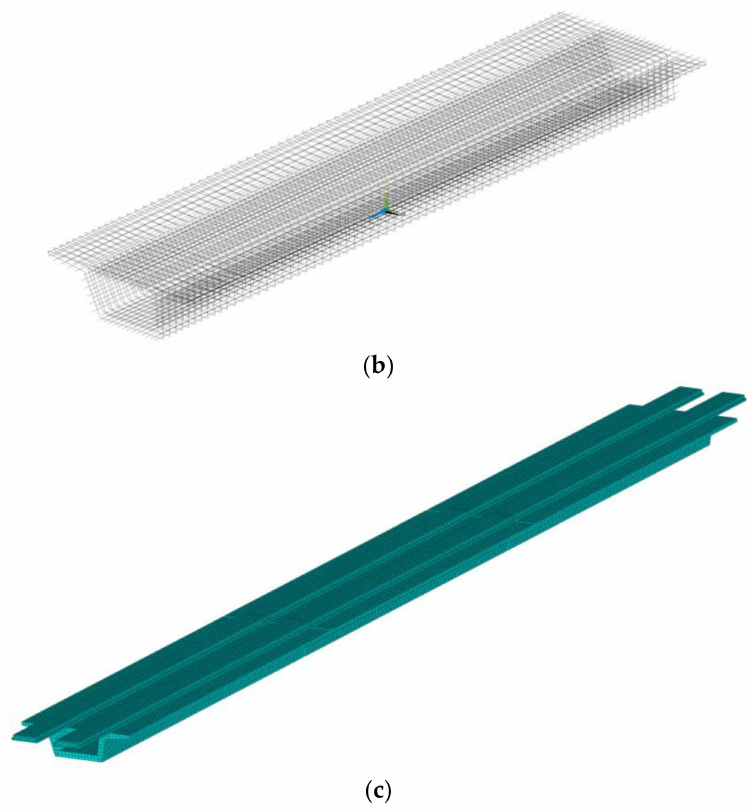
Figure 9. Finite element model of ballastless track–bridge structure: ( a ) Mesh of bridge–track cross- section; ( b ) longitudinal reinforcement and stirrups (one span); ( c ) sketch of finite element model of structural